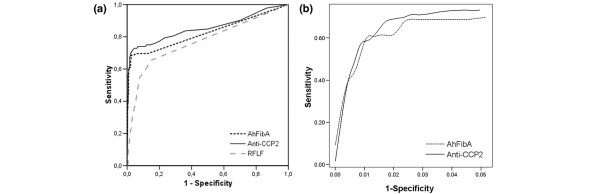
ROC curve analyses of the RF, AhFibA and anti-CCP2 assay in population 1. (a) The whole curve is shown, and (b) with a focus on detail of the ROC curve at the 98% specificity level for the AhFibA and anti-CCP2 assay in population 1. AhFibA, anti-human fibrinogen (auto)antibodies; CCP, cyclic citrullinated peptide; RF, rheumatoid factor; ROC, receiver operating curve.